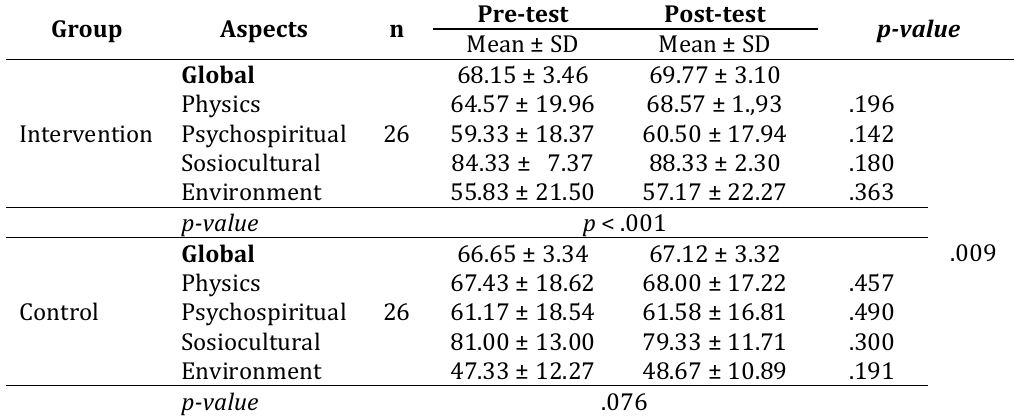
The distribution of aspects of comfort level (pre-test and post-test) (n=52)